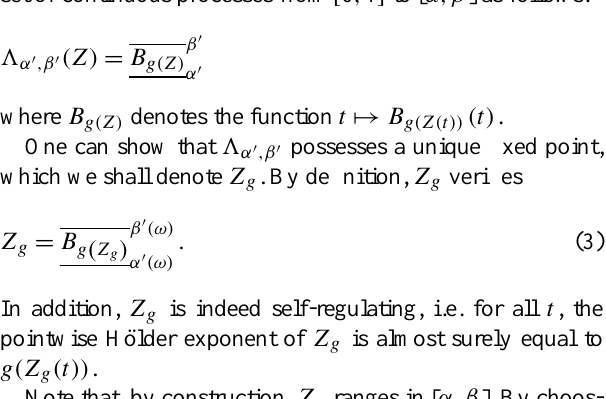
Fig. 3. Triangle function and dilated-translated versions.